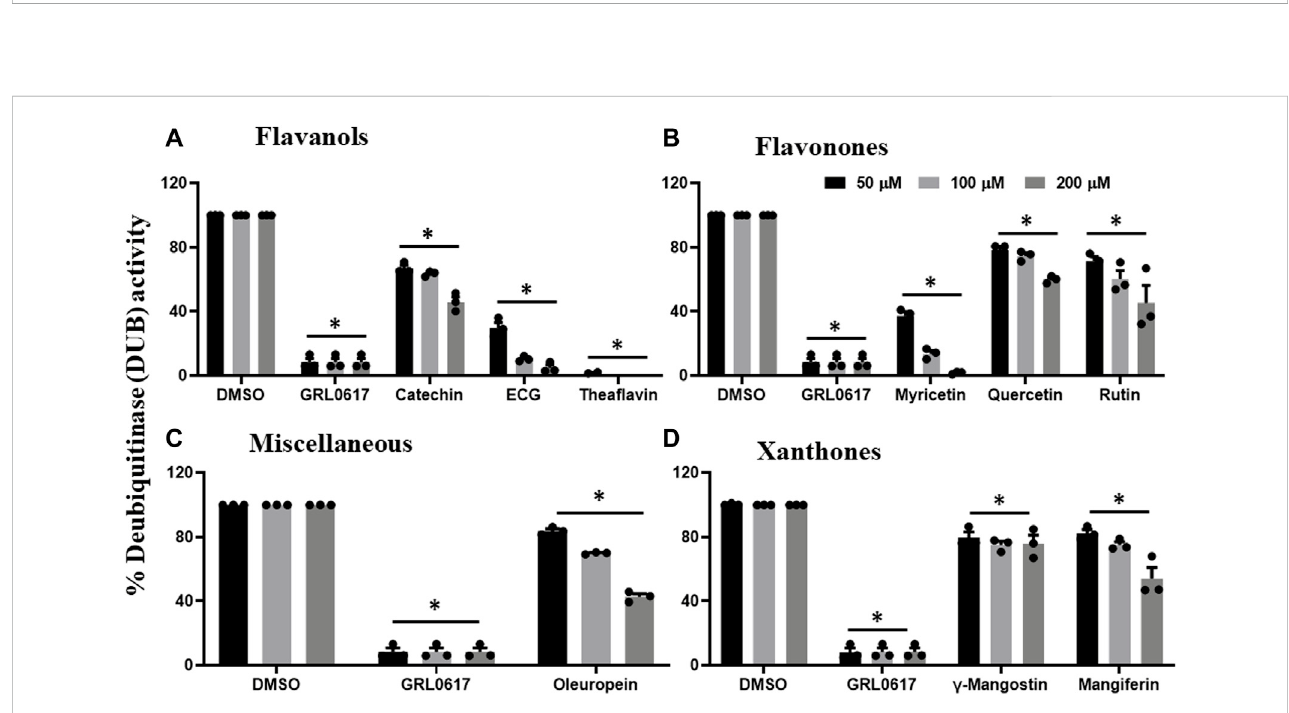
SelectedphytochemicalsFlavanols (A) ,Flavonones (B) ,MiscelleneousDrugs (C) ,andXanthones (D) thatexhibitedinhibitoryeffectagainstdeubiquitinase (DUB)activityofSARS-CoV-2PLproenzyme.PhytochemicalsthatinhibitedtheproteolyticactivityofSARS-CoV-2PLproenzymewereselectedandscreened for their inhibitory effect towards DUB activity as described under Materials and Methods. The fl uorescence intensity was used to calculate the percent DUB activity considering DMSO treated control as 100% activity. Blank values were subtracted before calculating the percent activity. Representatives of four individual experiments (n = 4) with triplicate values were presented graphically and analyzed using GraphPadPrism 8. p -values < .05 considered as statistically signi fi cant compared to the DMSO